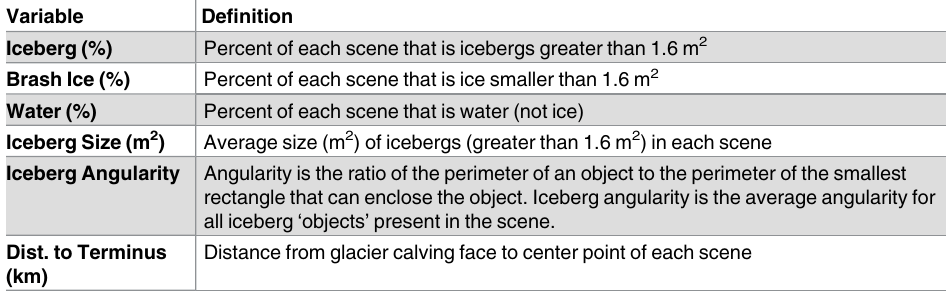
Table 1. Variables extracted from each scene using object-based image